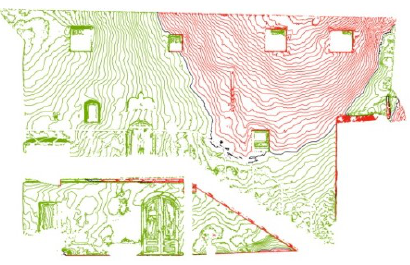
Figure 4: North-West Facade